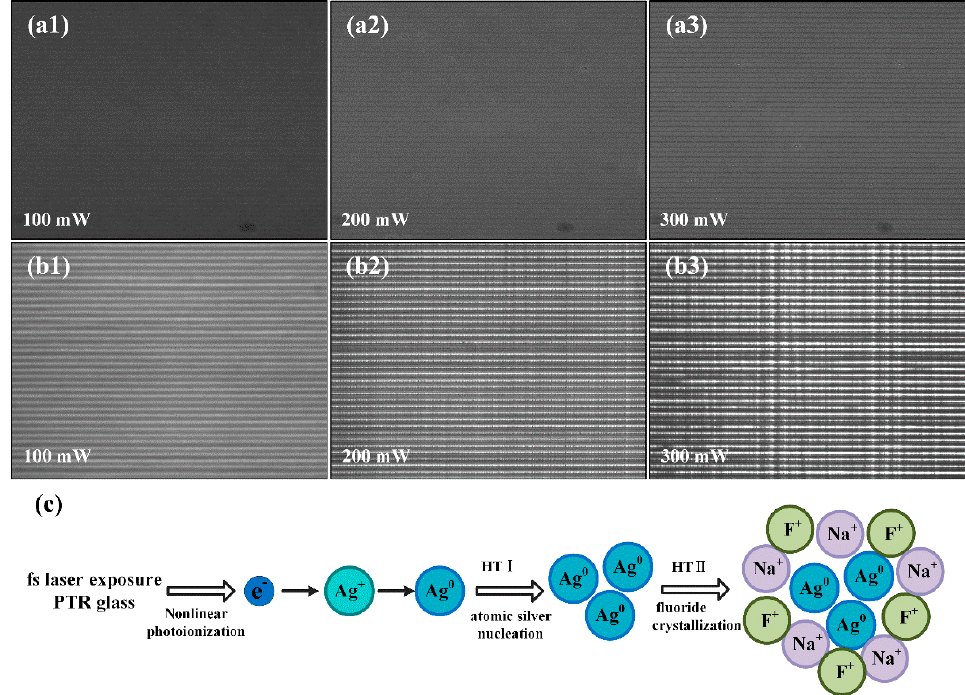
Figure 2. PCM images of parallel tracks before HT ( a ) and after HT ( b ) with different writing powers of 100, 200 and 300 mW. The index change is positive following laser action and turns negative following heat action. ( c ) Schematic for the nonlinear photo-thermo-induced crystallization mechanism in PTR